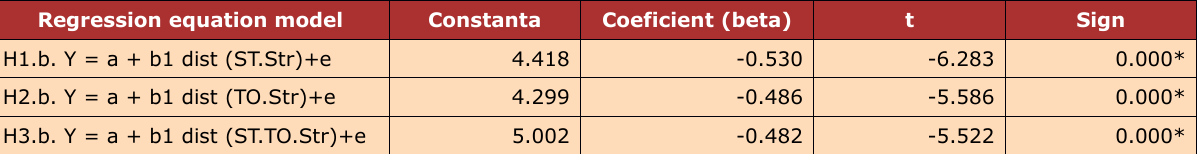
Table 7. The result of Hypothesis Testing Reactive Strategy (n =